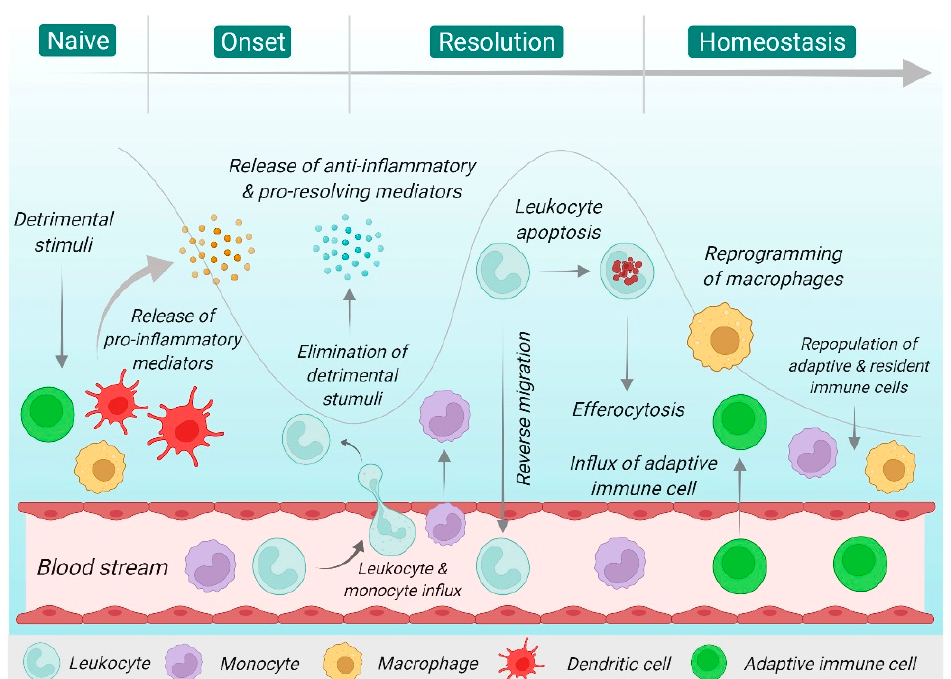
Figure 1. Cellular events during an acute inflammatory response.